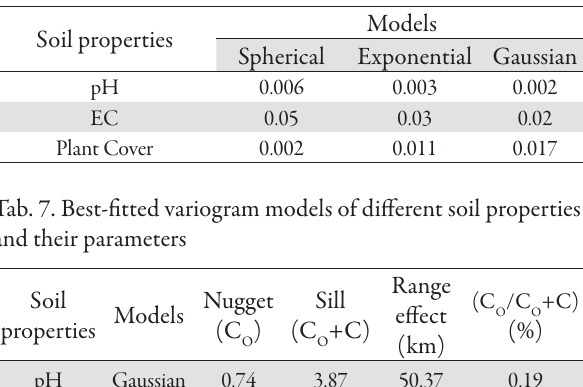
Tab. 6. Selecting of most suitable model on experimental variogram according to RSS values Soil properties